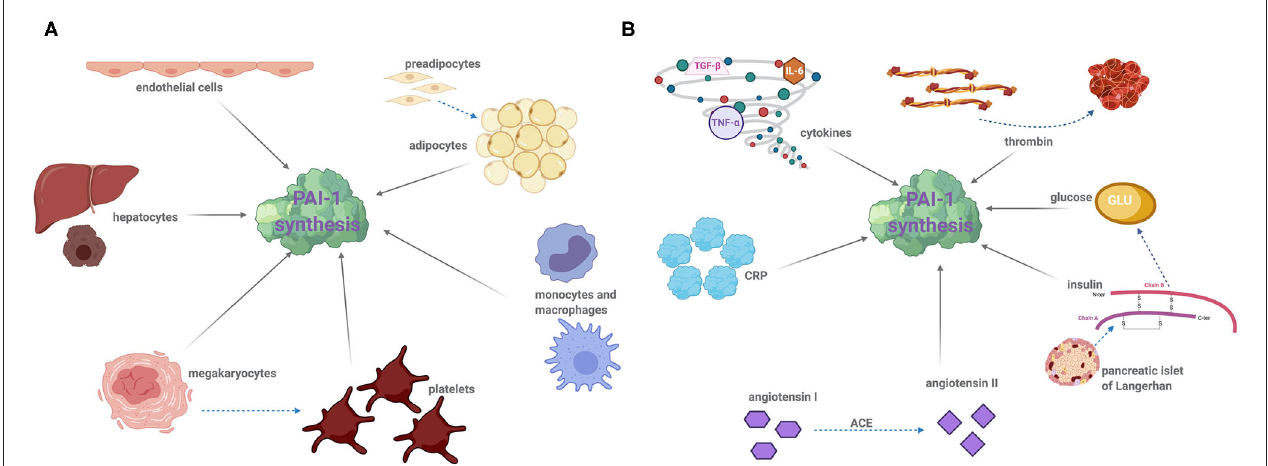
FIGURE 1 | Cellular sources of PAI-1 of modulators of synthesis: (A) PAI-1 is produced by a variety of cell types including the following: endothelial cells, adipocytes, hepatocytes, leukocytes (monocytes and macrophages), megakaryocytes, and platelets. Dotted arrows demonstrated cell differentiation and solid arrows indicate PAI-1 synthesis. (B) A number of factors induce PAI-1 synthesis and secretion. Proinflammatory cytokines, namely interleukin-6 (IL-6), tissue necrosis factor alpha (TNF- α ), and transforming growth factor beta (TGF- β ) significantly augment PAI-1 synthesis. Thrombin, insulin, glucose, angiotensin II, and C-reactive protein